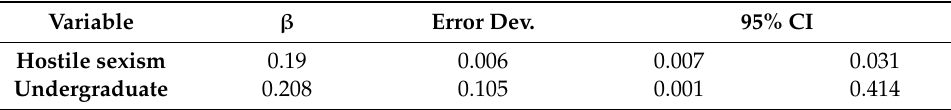
Table 5. Multiple linear regression model for the love-abuse link. Variable β Error